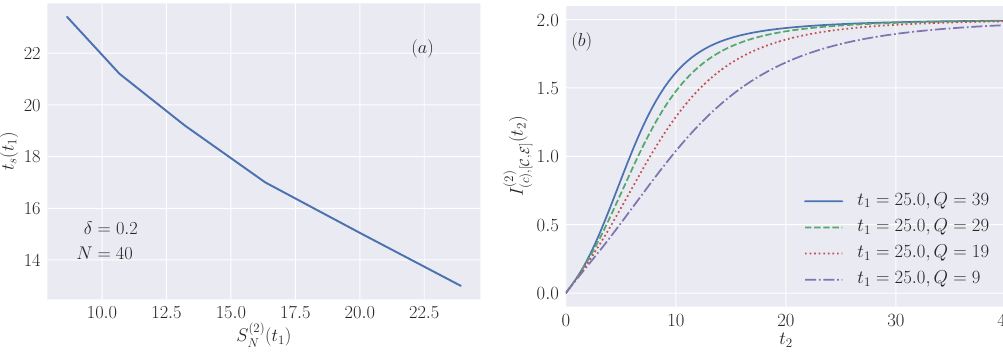
Figure 14 . Sub(cid:12)gure ( a ): scrambling time t s ( t 1 ) as a function of S (2) ( t 1 ). Here t s ( t 1 ) is de(cid:12)ned as N the value of t 2 at which I (2) ( t 2 ) reaches the value 2 (cid:14) . In the plot, we chose (cid:14) = 0 : 2. ( c ) ; [ C ; E ] (cid:0)